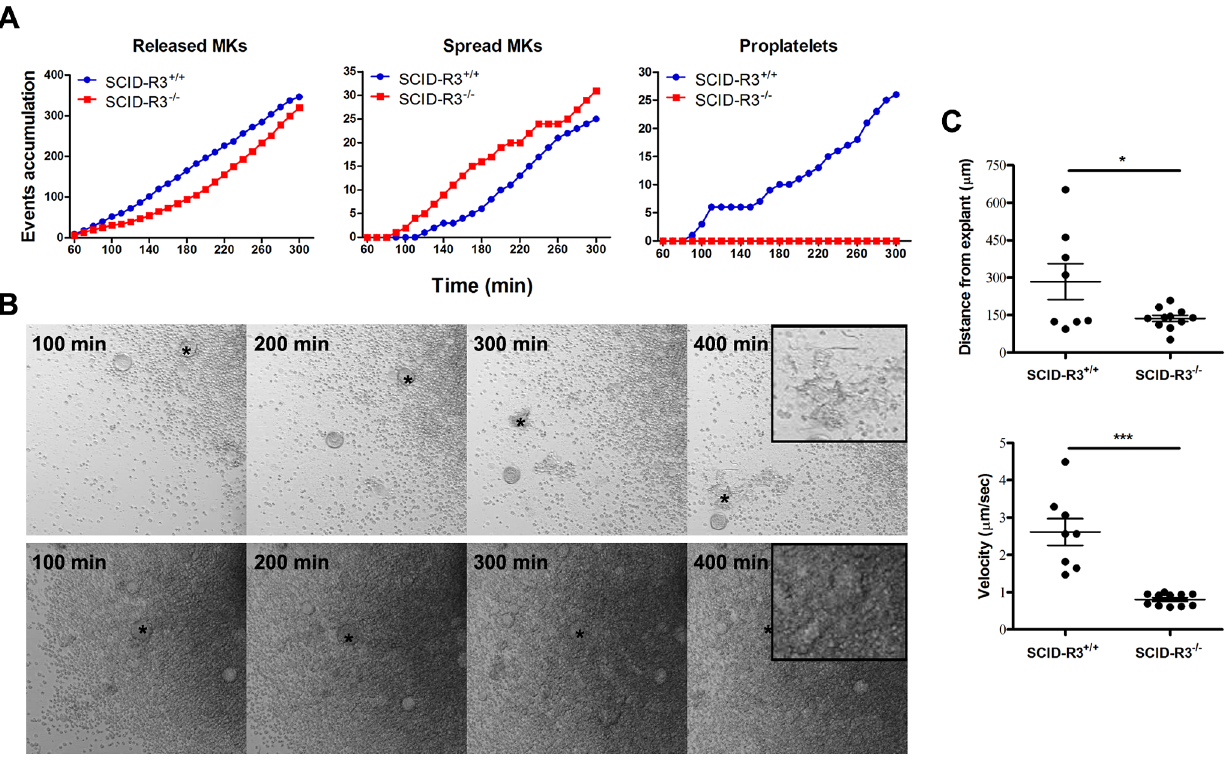
Figure 2. Altered SCID-Rasa3 2 / 2 megakaryocyte motility, adhesion and differentiation into proplatelet forming megakaryocytes. Femur bone marrow explants were isolated from SCID-Rasa3 + / + and SCID-Rasa3 2 / 2 mice 2 months after irradiation/reconstitution and cultured under a confocal microscope. Images were taken in bright field every 10 min. A. Number of megakaryocytes released from the explants (left panel), of spreading megakaryocytes (center panel) and of proplatelet forming megakaryocytes (right panel). Results are representative of 3 independent experiments. B. Example of megakaryocytes released from a SCID-Rasa3 + / + (upper panels) and a SCID-Rasa3 2 / 2 (lower panels) explant. The asterisk indicates the same megakaryocyte that finally develops into a proplatelet forming megakaryocyte (SCID-Rasa3 + / + explants) or that continuously adheres to the culture plate and fail to form proplatelets (SCID-Rasa3 2 / 2 explants). Insets: higher magnification shows the proplatelet forming megakaryocyte in the SCID-Rasa3 + / + explants and the adherent megakaryocyte in the SCID-Rasa3 2 / 2 explants. Scale bars: 50 m m. C. Velocity and linear distance covered by individual megakaryocytes 3 hours after release from SCID-Rasa3 + / + and SCID-Rasa3 2 / 2 explants. Statistics (unpaired t test): *: P , 0.05; ***: P , 0.001.